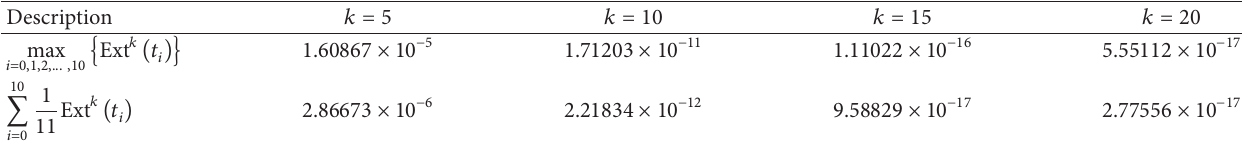
Table 1: The maximum and average exact error function of 𝑥 𝑘 (𝑡) at 𝑘 = 5,10, 15, 20 .